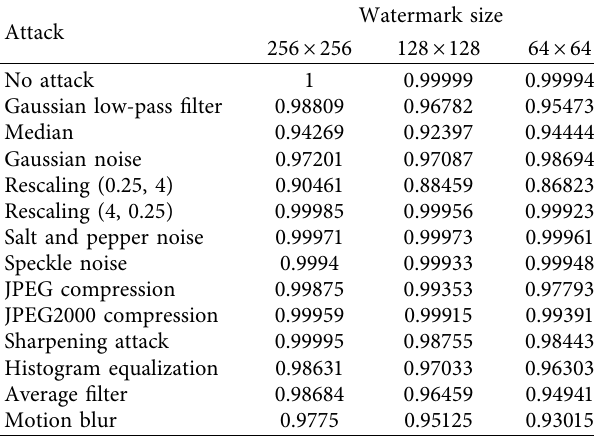
Table 4: The robustness performance of the watermarked blood image obtained using different-sized